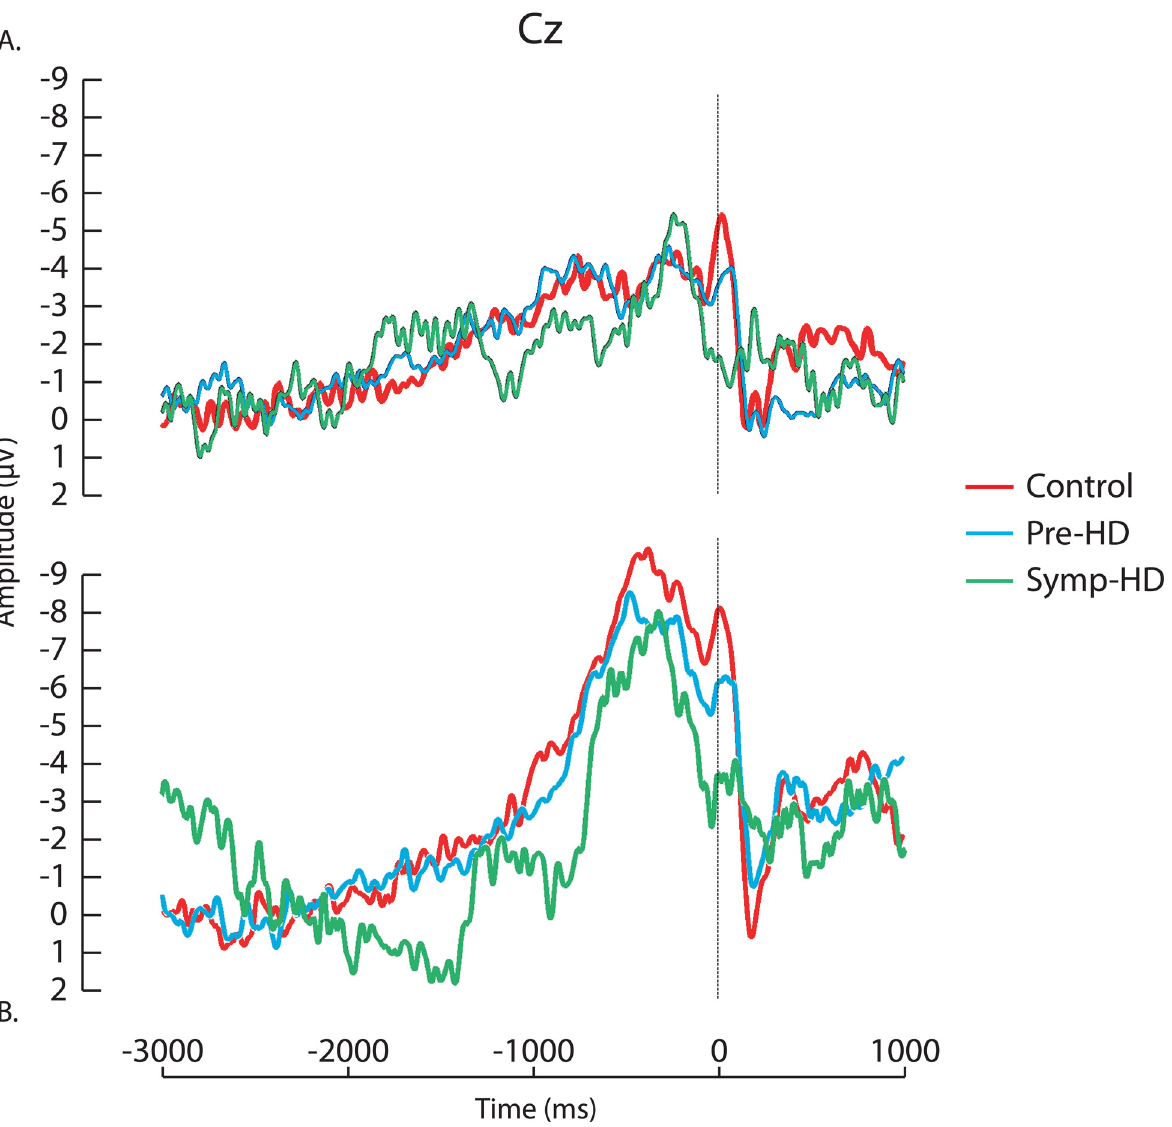
Fig 1. Tapping Task 1 (cued and self-paced Conditions). Grand average Readiness Potential (RP) waveforms are shown at Cz for each of the control, pre-HD and symp-HD groups. (A) cued tapping. (B) Self-paced tapping. Time ‘ 0 ’ represents the time of motor response (right index finger button press).